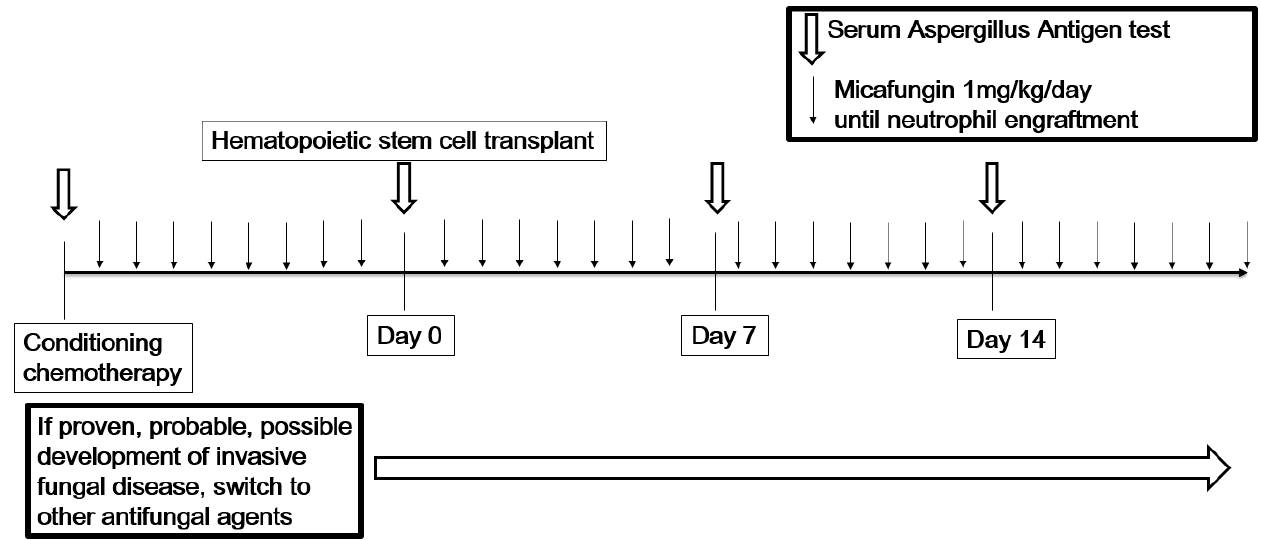
Figure 1. Treatment scheme of the study.